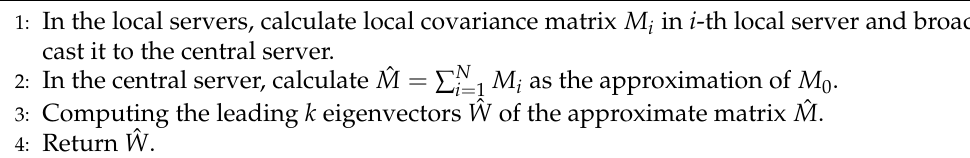
Algorithm 1 One-shot Distributed GEP algorithm (DGEP).